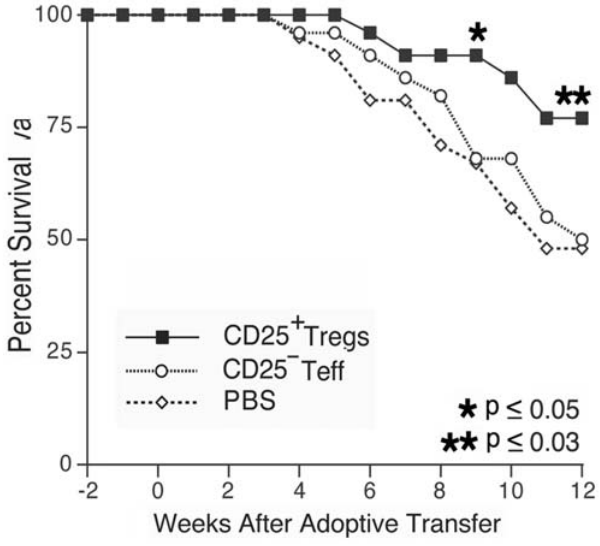
Figure 10. Prolonged survival in T reg treated mice. Mice receiving adoptive transfer of T regs had significantly prolonged survival first evident 9 weeks after transfer (p , 0.05 at week 9) as compared to either control group.